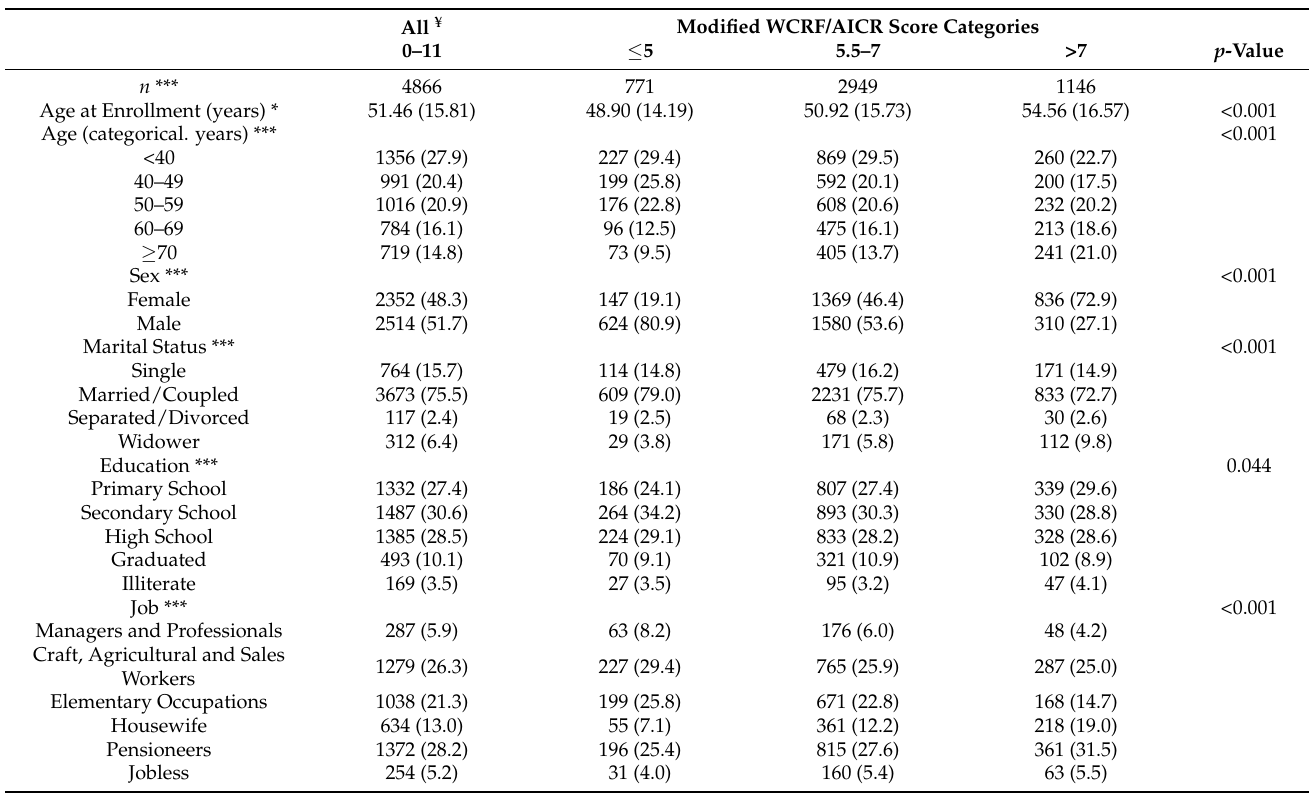
Table 2. Characteristics of participants by modified WCRF/AICR score categories. MICOL/PANEL and NUTRIHEP Studies. Castellana Grotte. Putignano (BA). Italy.